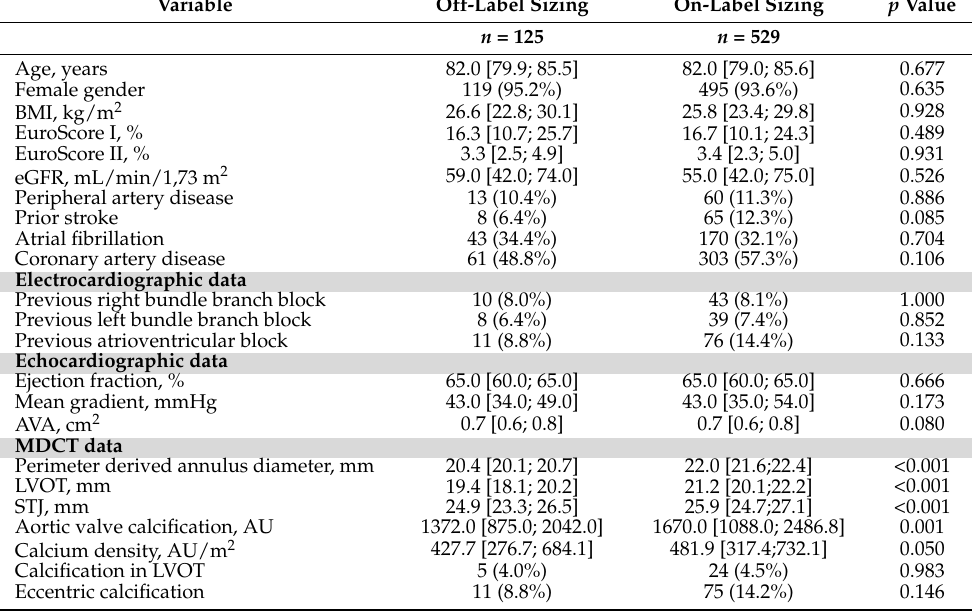
Table 1. Baseline